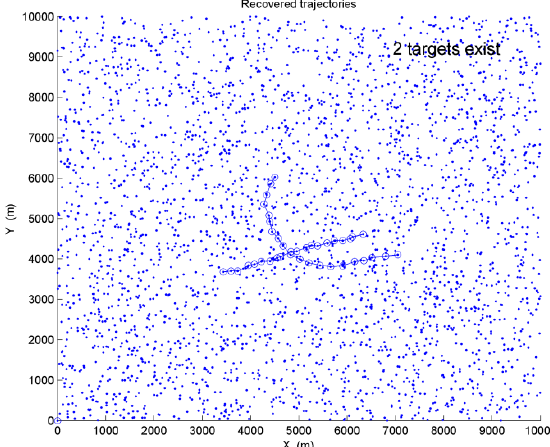
Figure 7. Recovered trajectories and estimated target number.